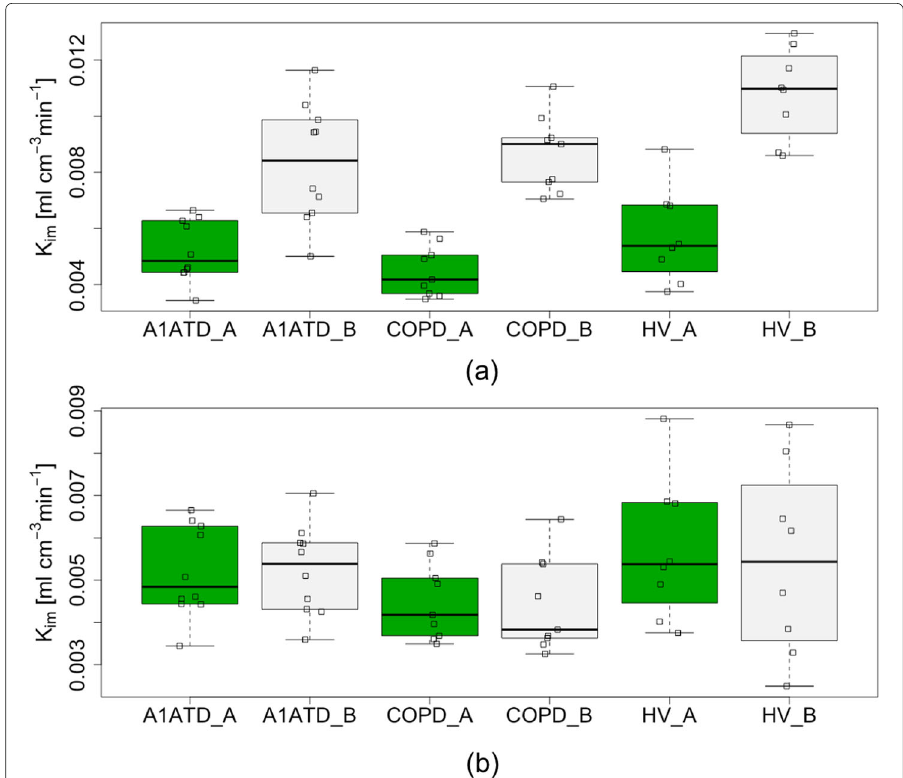
Fig. 3 Boxplot of group differences in K im between the two analysis pipelines. ( a ) Initial comparison between K im between the two analysis pipelines. ( b ) Comparison between K im between the two pipelines after all adjustments to Pipeline B (see section Further investigation). COPD=ChronicObstructivePulmonaryDisease, A1ATD= α